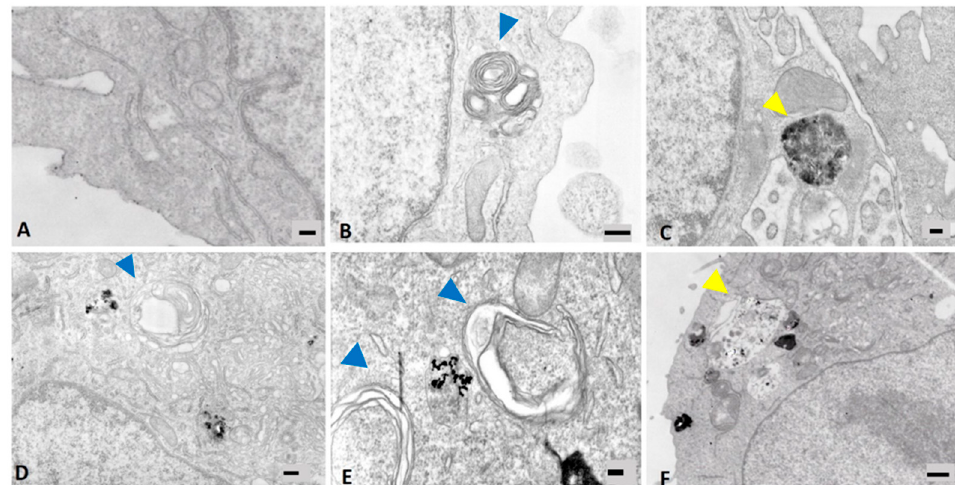
Figure 6. TEM analyses of A549 cells after 24 h exposure to particles. ( A ): ctrl (100 nm); ( B ): ZnO 10 µ g/mL (300 nm); ( C ): DEP + ZnO 10 µ g/mL (200 nm); ( D ): DEP 100 µ g/mL (300 nm); ( E ): CuO 10 µ g/mL (200 nm); ( F ): DEP + CuO 10 µ g/mL (200 nm). Blue arrows indicate multilamellar bodies (MLBs); yellow arrows indicate autophagosomes.